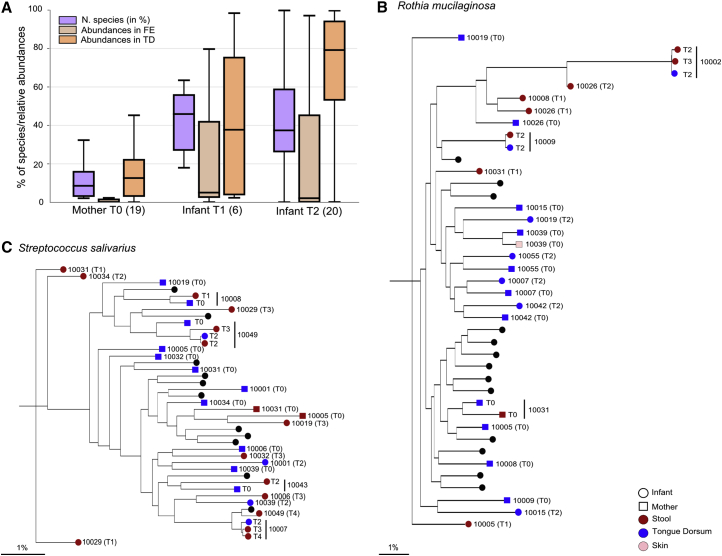
Infants Have More Shared Species and Strains between the Oral and Gut Microbiome Than Their Mothers(A) Number of shared species normalized by the total number of species present in the gut and the tongue dorsum of each subject, and the cumulative abundances of shared species in the two body sites. The number of samples considered for the analysis is reported in parentheses.(B and C) Transmission trees for Streptococcus salivarius (B) and Rothia mucilaginosa (C). Only pairs with more than two samples present in the tree are shown (black circles otherwise).